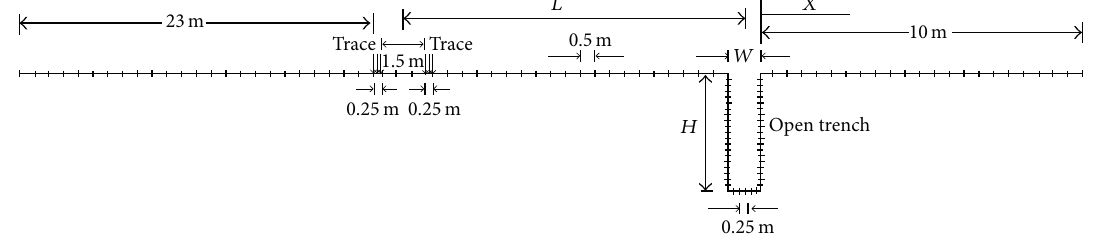
Figure 2: The typical mesh of open trench